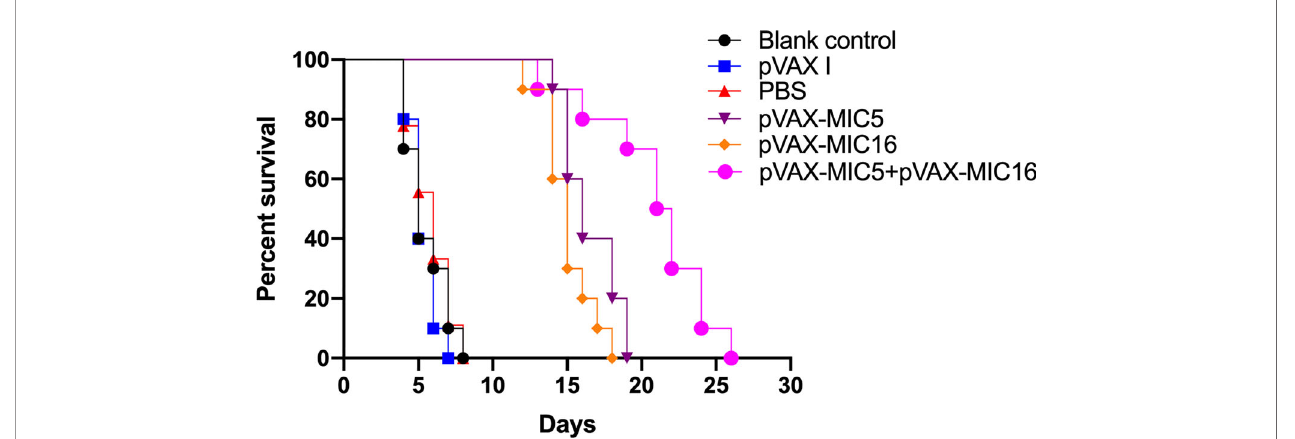
FIGURE 5 | The survival rate of immunized Kunming mice challenged with 1 × 10 3 tachyzoites 2 weeks after the last immunization.